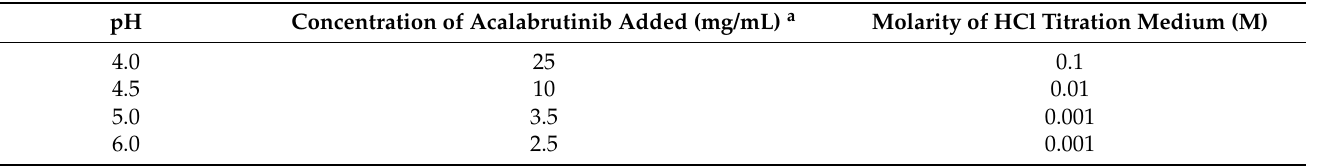
Table A7. Concentrations of acalabrutinib added and molarities of titration media for pH-solubility measurements. pH